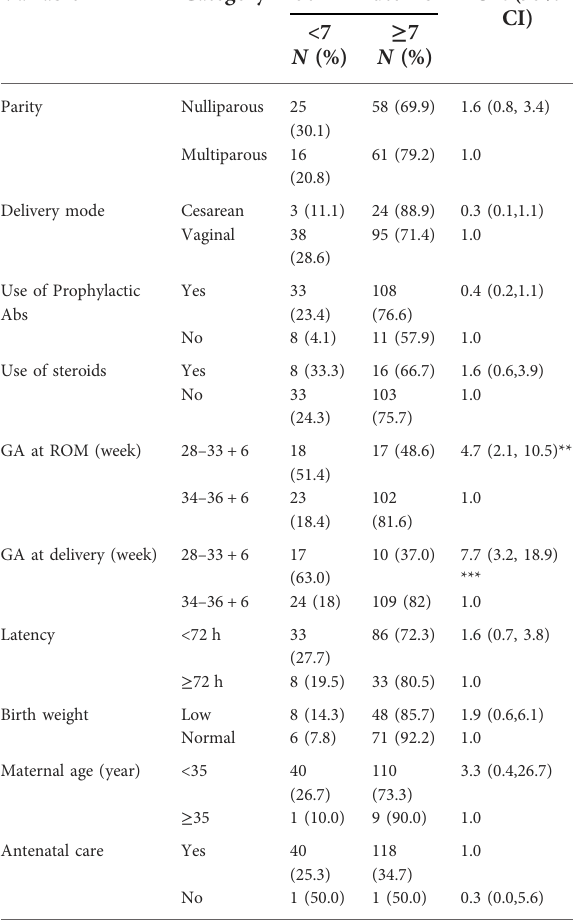
TABLE 3 Factors determining NICU admission among pregnant women with preterm premature rupture of membrane.